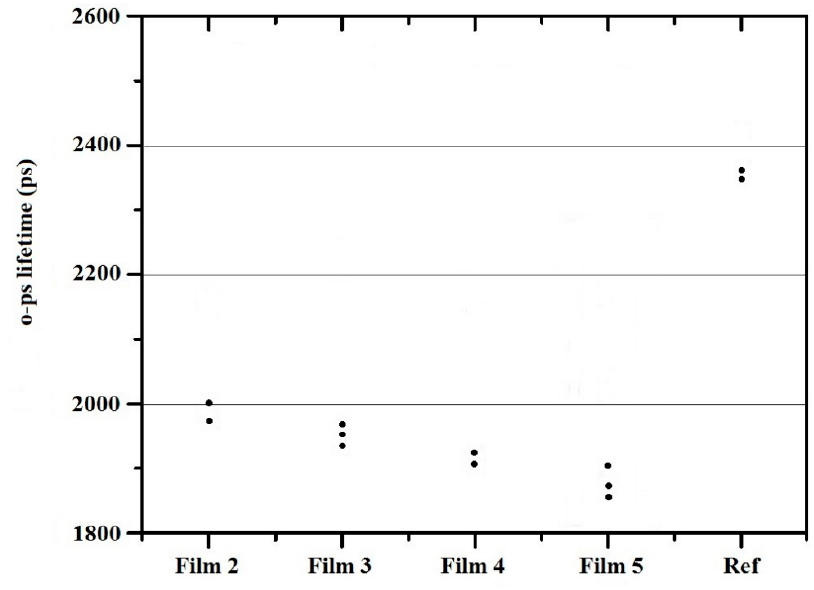
Figure 6. The results of PALS